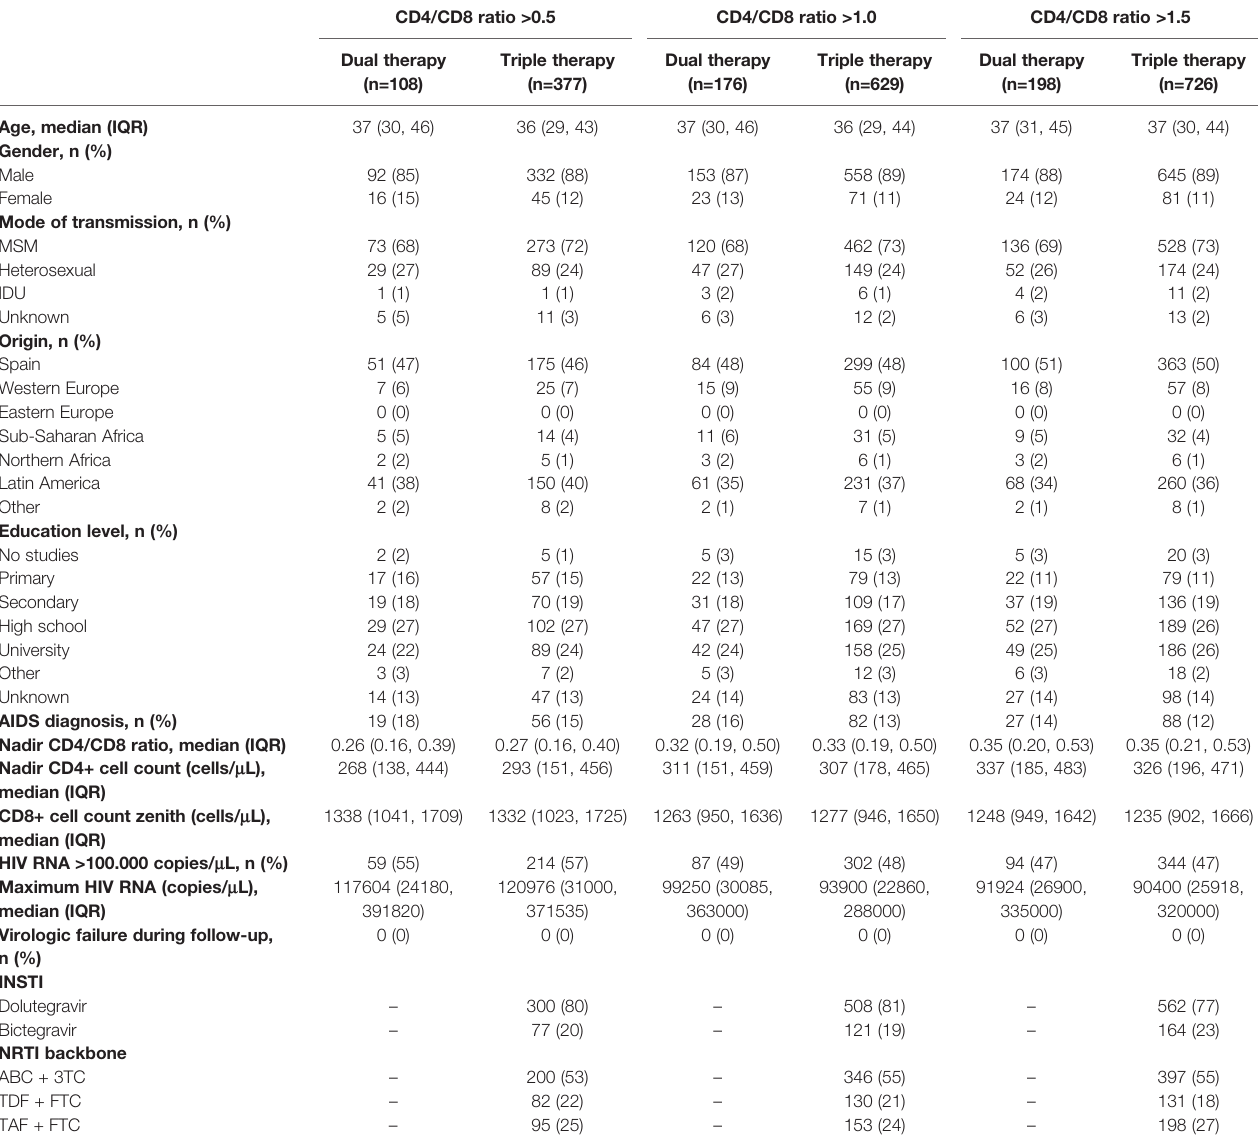
TABLE 1 | Population baseline characteristics according to the ART